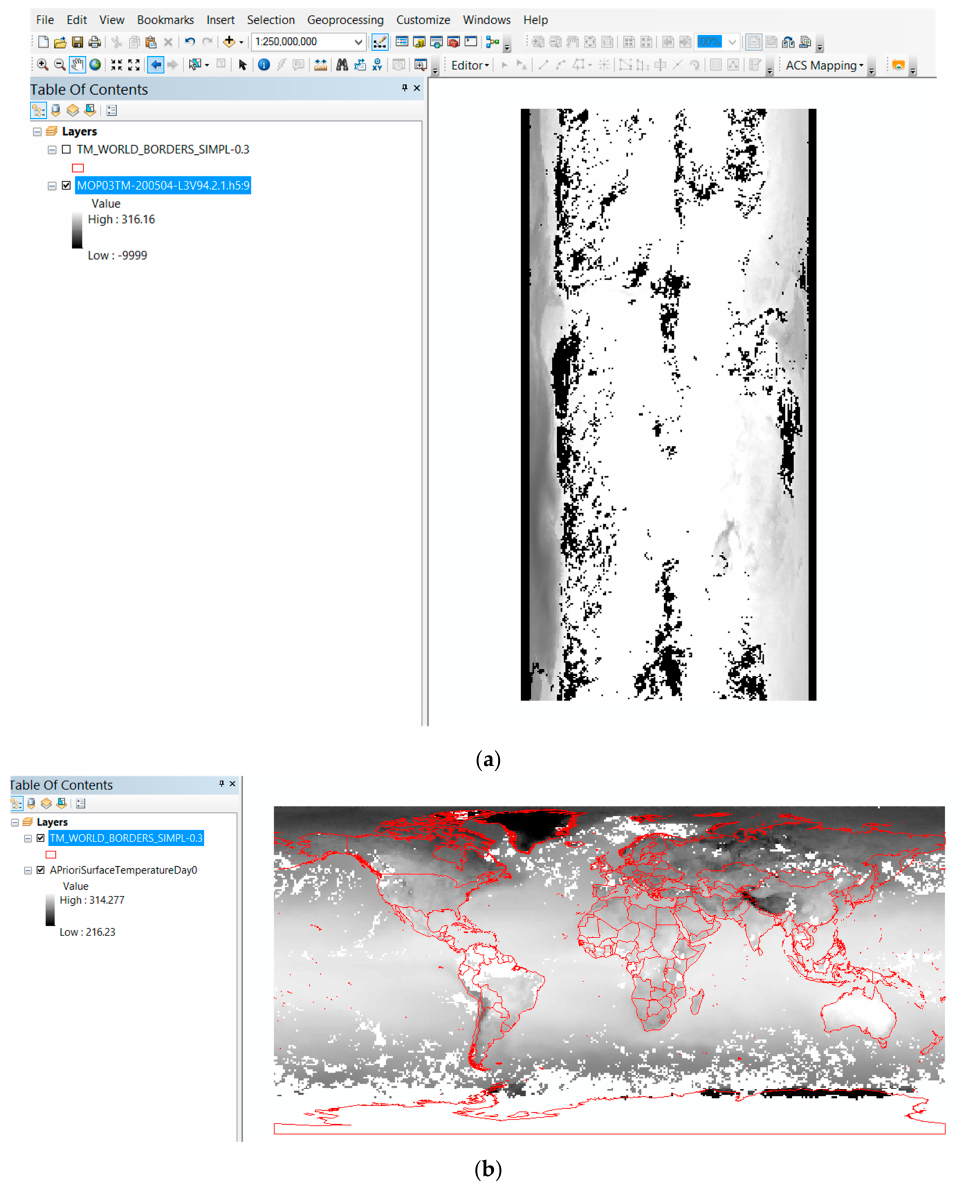
Figure 13. Image, 90 degree rotated ( a ) compared to the correct interpretation ( b ) after incorporating the enhanced